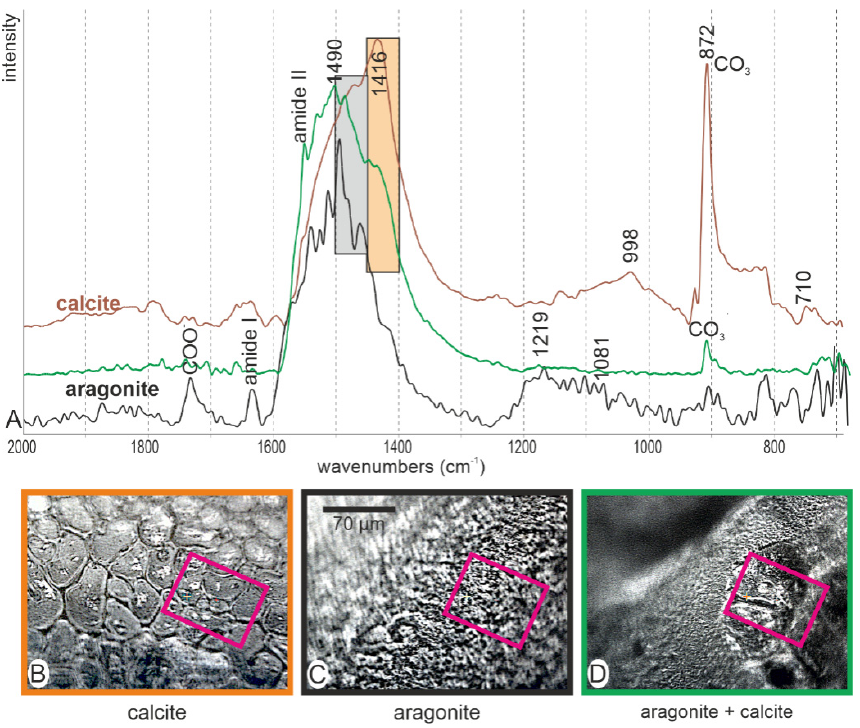
Figure 9. FTIR spectra of first deposits: prismatic calcite ( A , B ), microgranular aragonite ( A , C ) and a mixed zone ( A , D ). Grey rectangle: range of ν 3 band for aragonite; orange rectangle; range of ν 3 band for calcite.